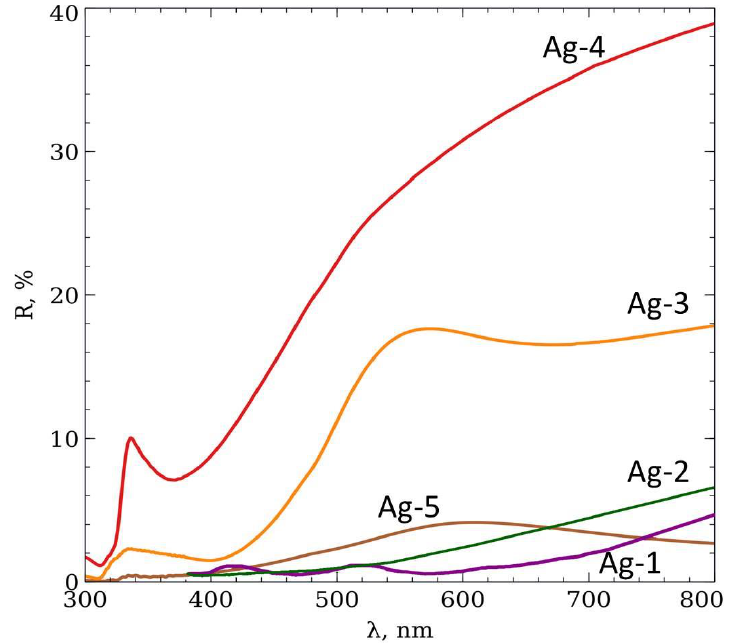
Figure 5. Specular reflectance spectra of the Ag inverse opals (the spectra were collected for five samples under equal incidence angle ~8°).